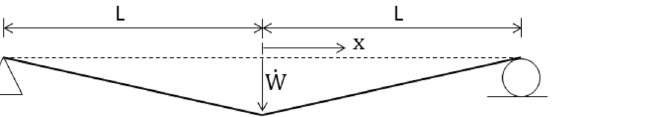
Figure 17. Distribution of transverse velocity during stationary plastic hinge third phase of motion ( ν > 1.5